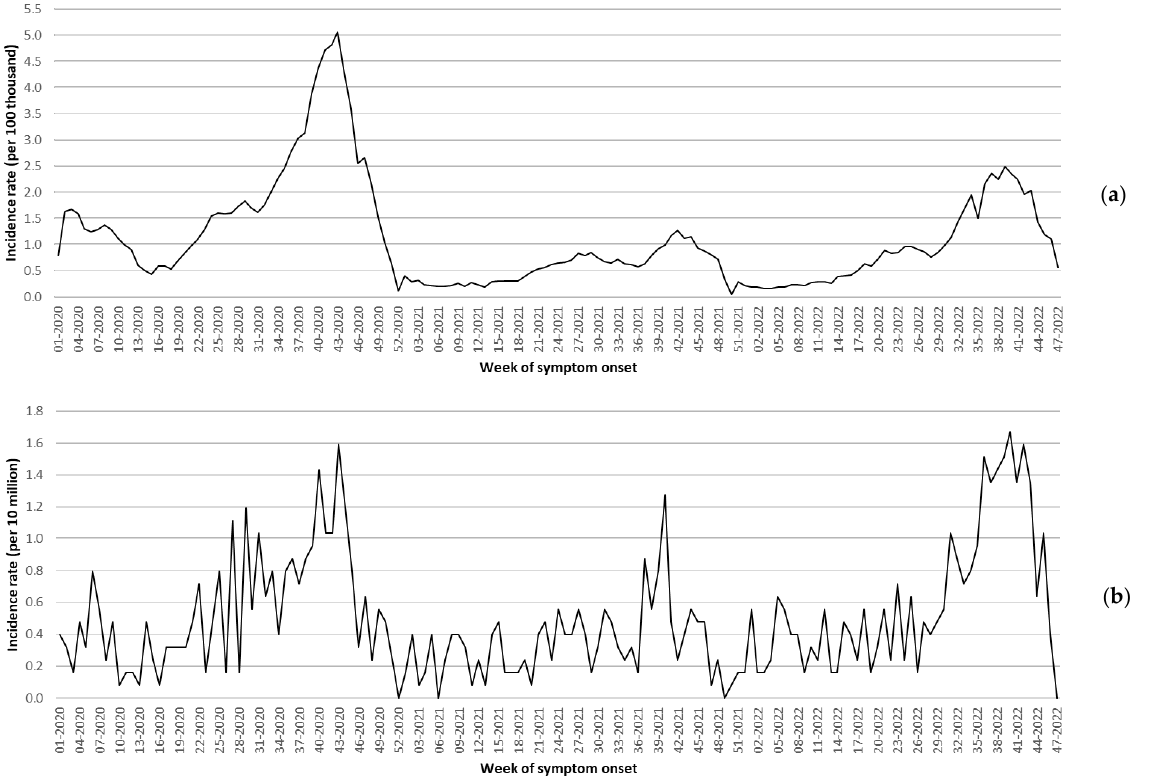
Figure 1. Incidence rates of non-fatal ( a ) and fatal ( b ) dengue fever cases, Mexico 2020–2022. Note: by the date of the 2022 data collection, information from weeks 48 to 52 was not